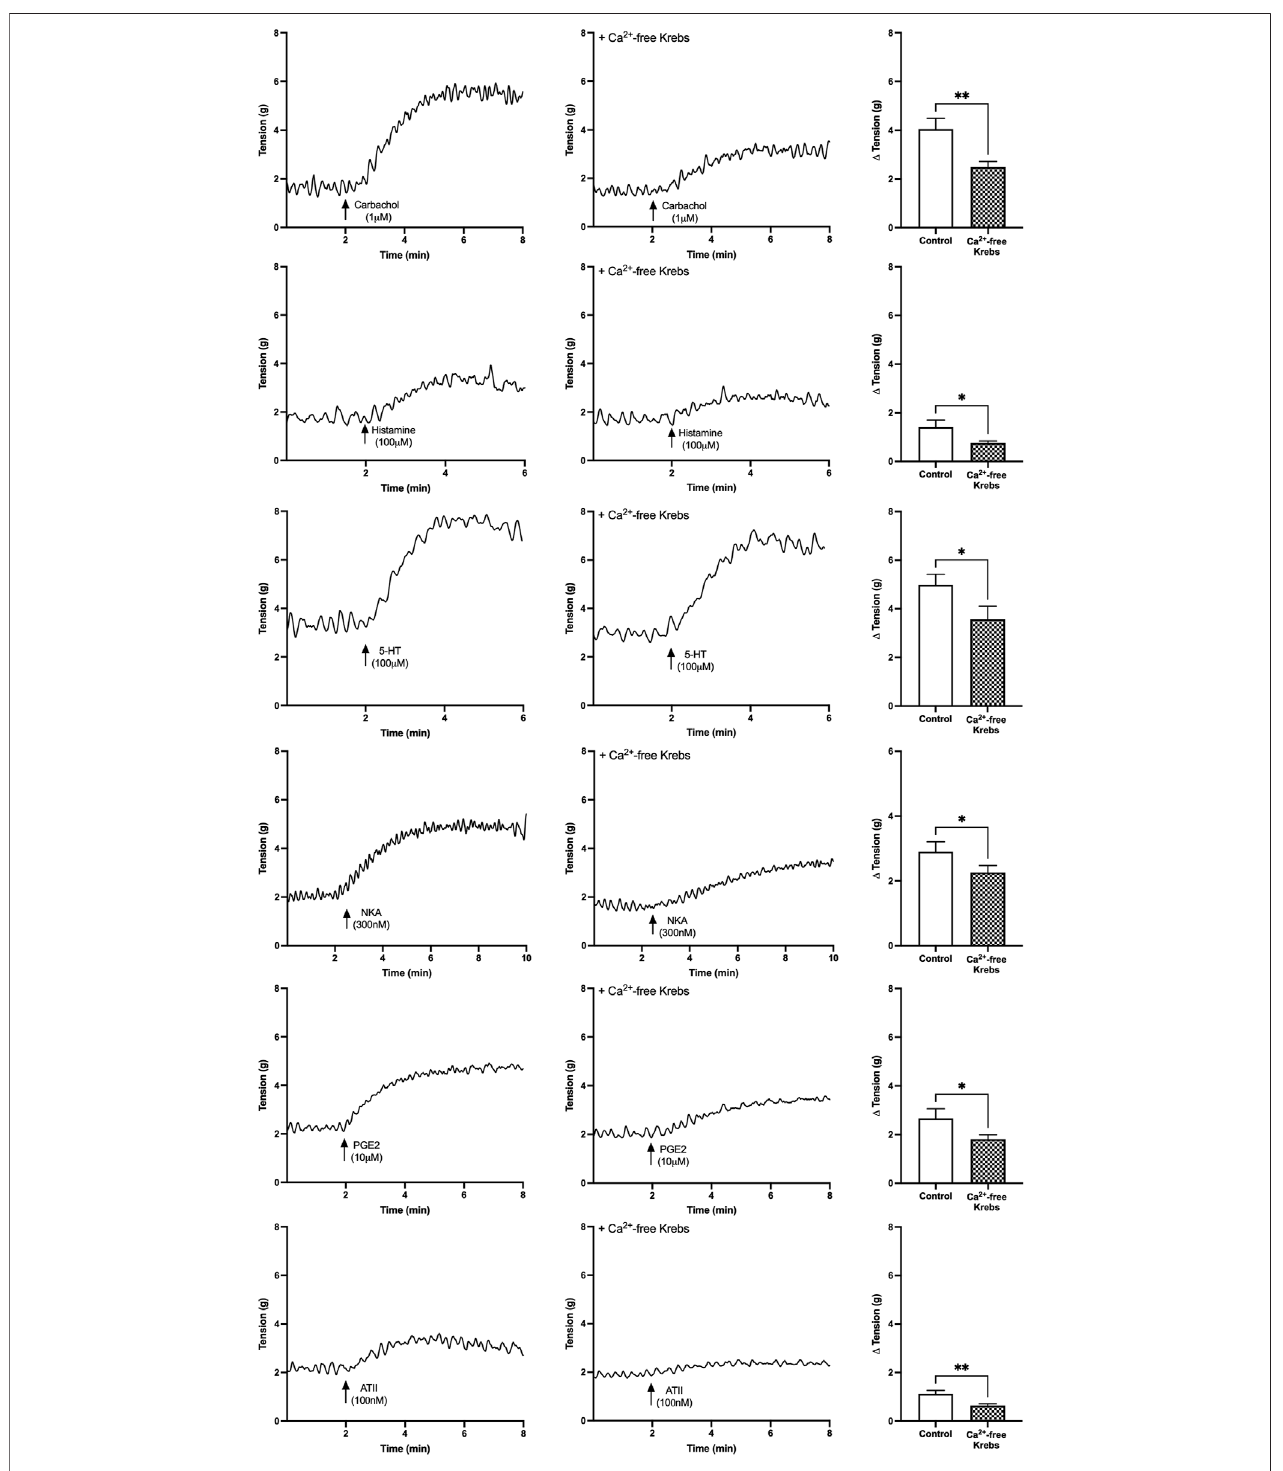
FIGURE 2 | U&LP baseline tension responses to receptor agonists carbachol (1 µM), histamine (100 µM), 5-HT (100 µM), NKA (300 nM), PGE2 (10 µM), and ATII (100 nM) as controls in the normal Krebs (left) and in nominally zero Ca 2+ solution (right). * p < 0.05, ** p < 0.01, *** p < 0.001 (paired Student ’ s two-tailed t -test).